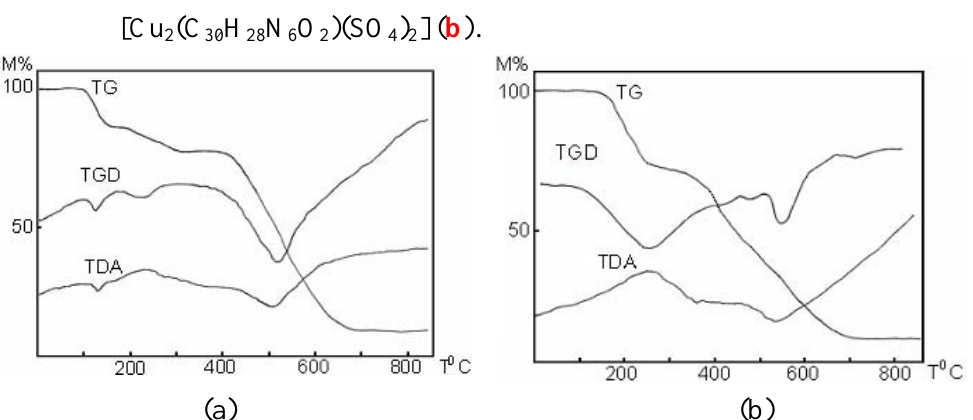
Figure 2. TG, DTG and ATD curves for: Cu(C